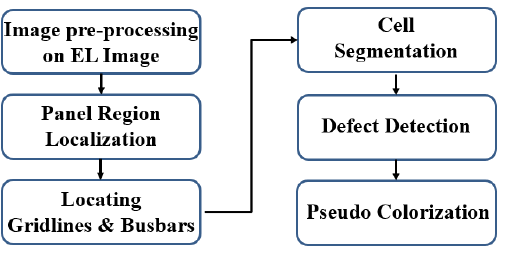
Figure 2. Flowchart of the SCDD method.